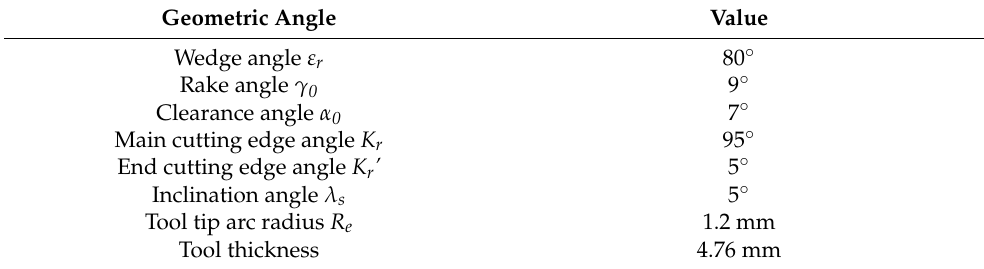
Table 1. Geometric angles of the tools.